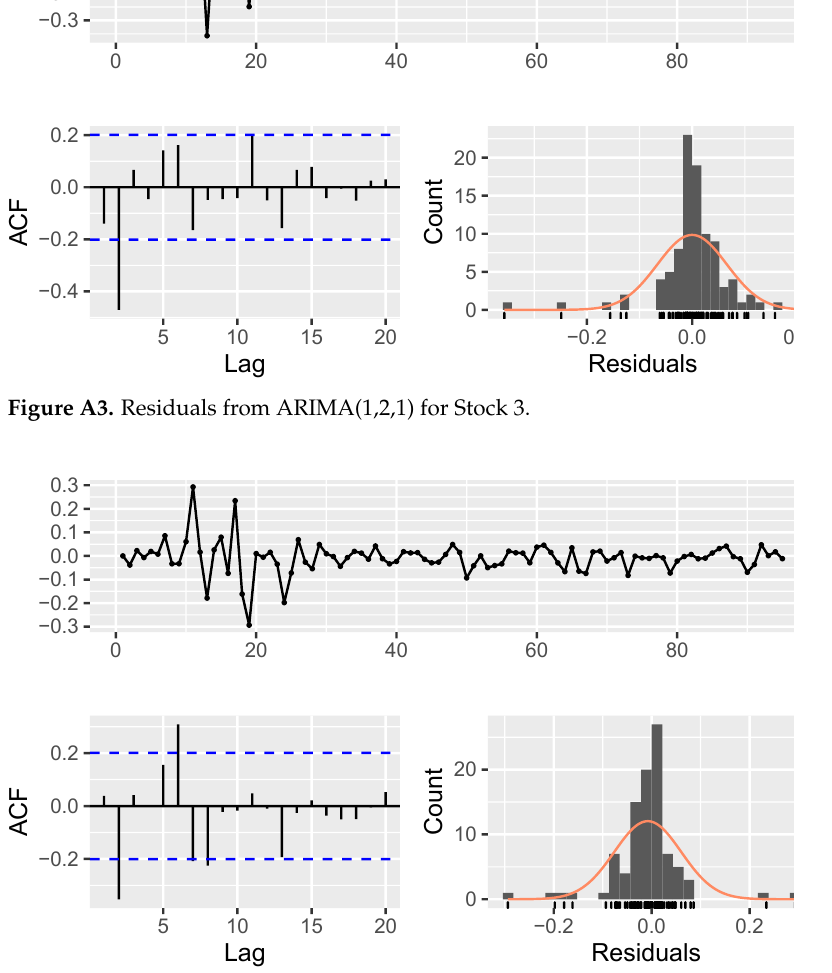
Figure A4. Residuals from ARIMA(1,1,1) for Stock 4.